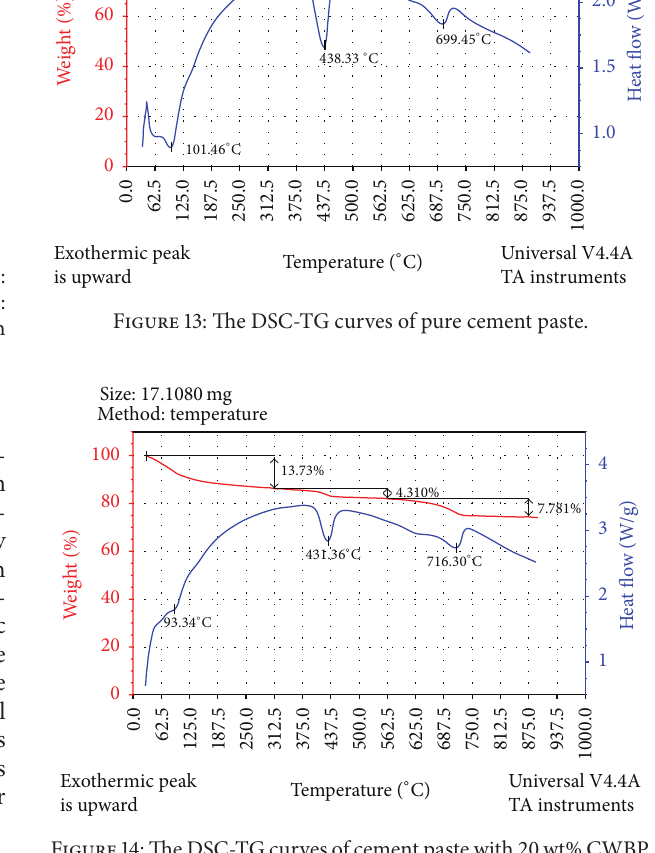
Figure 14: The DSC-TG curves of cement paste with 20wt%